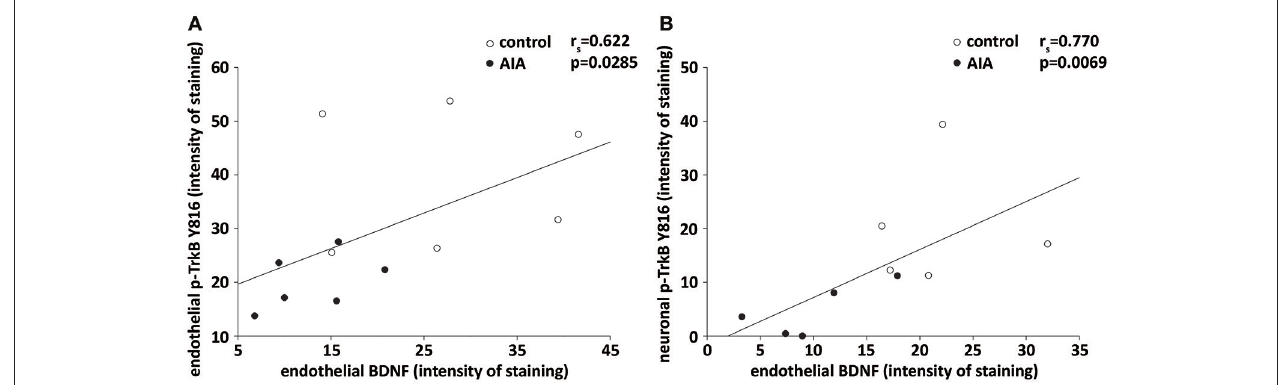
FIGURE 3 | (A) In cerebral microvessels-enriched fractions, endothelial BDNF and p-TrkB Y816 staining were correlated when AIA ( n = 6) and control rats ( n = 6) were simultaneously examined, (B) on brain slices, endothelial BDNF staining of hippocampal arterioles correlated with p-TrkB Y816 staining in CA1 neurons when AIA ( n = 5) and control rats (5) were simultaneously examined. r s = spearman correlation coefficient.